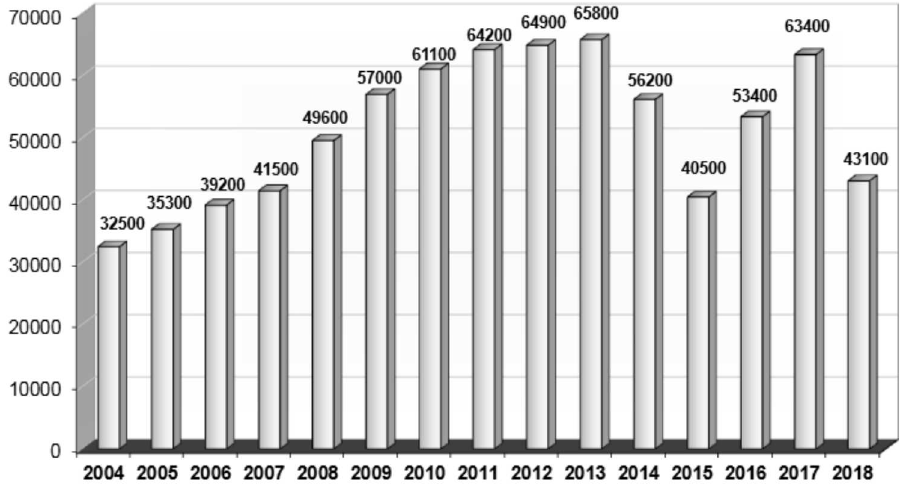
Graph 2. Number of applications allocated to the judicial formation (47 member states) between